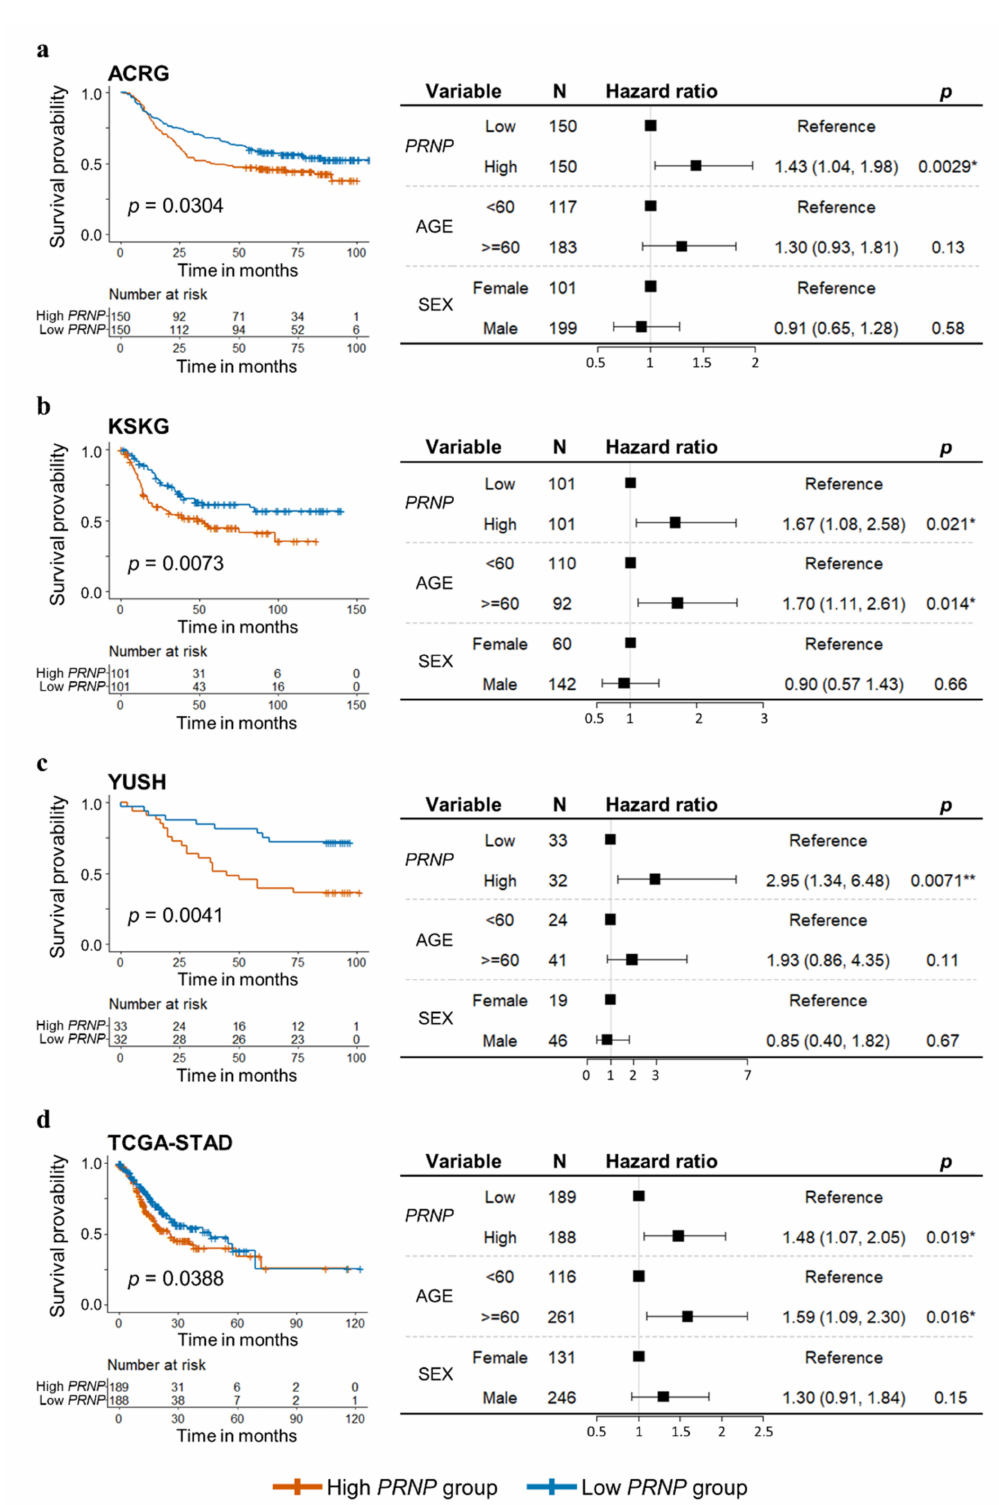
Figure 2. Kaplan–Meier curves, log-rank tests, and Cox proportional hazards model according to mRNA expression of PRNP . In all cohorts, the high- PRNP group had lower survival rates than the low- PRNP group. ( a ) Correlation of PRNP expression with overall survival in the ACRG cohort. ( b ) Correlation of PRNP expression with overall survival in the KSKG cohort. ( c ) Correlation of PRNP expression with overall survival in the YUSH cohort. ( d ) Correlation of PRNP expression with overall survival in the TCGA cohort. Black squares represent the hazard ratio. *, p < 0.05; **, p <